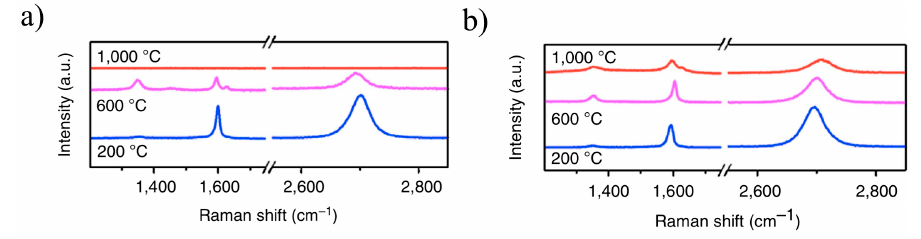
Figure 14. Raman spectra evolution with increasing temperature of ( a ) graphene; ( b ) hBN-coated graphene. Reprinted with permission from ref. [169]. Copyright 2013 Springer Nature.